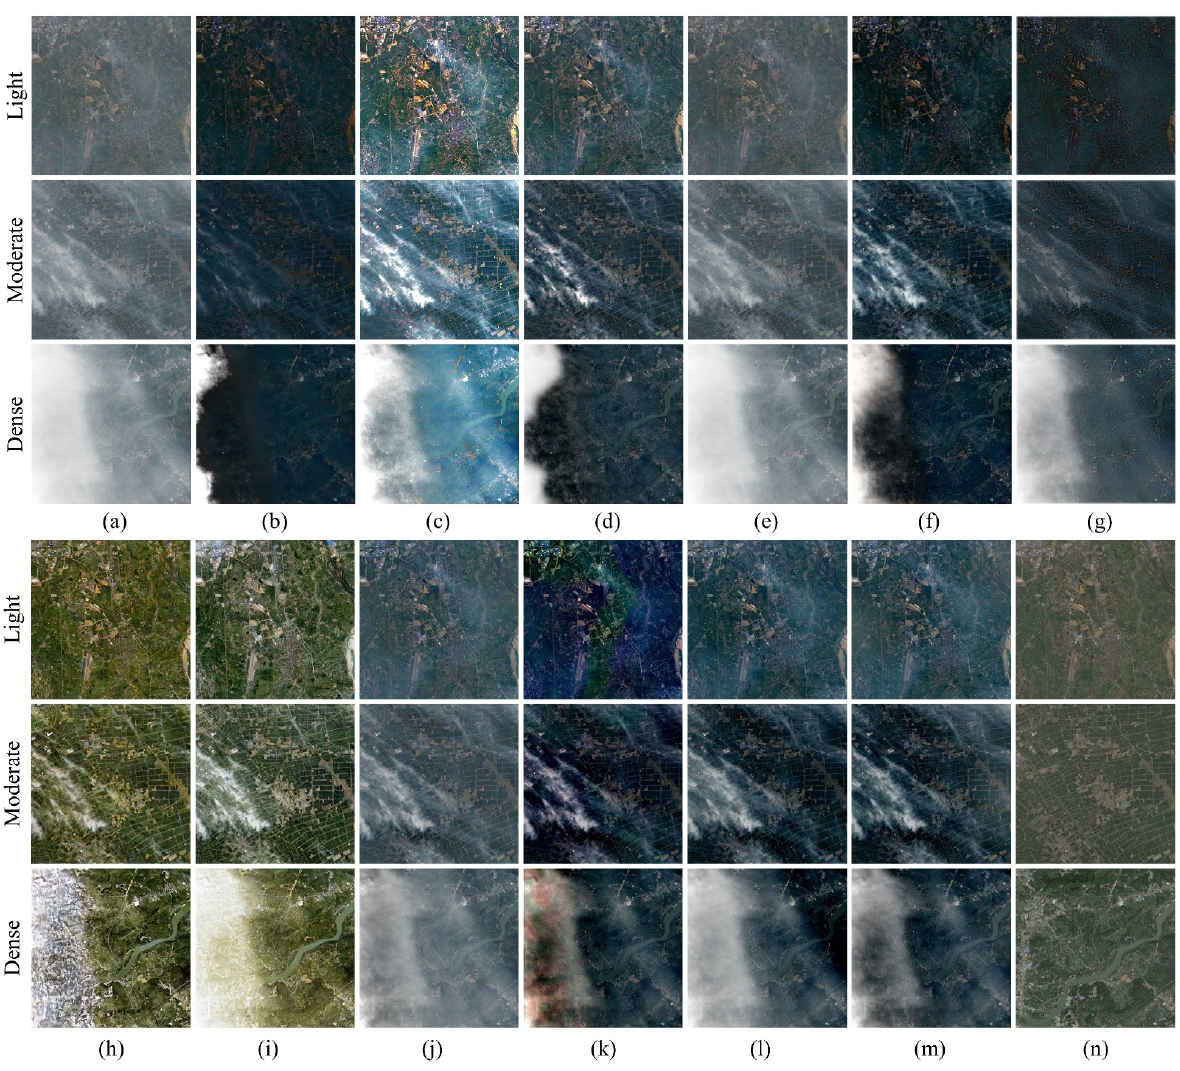
Figure 6. Comparisons with SOTA dehazing methods on the RS-Haze dataset. ( a ) Hazy input image. ( b ) DCP. ( c ) MOF. ( d ) BCDP. ( e ) FFA. ( f ) EMRA. ( g ) LDN. ( h ) AESUN. ( i ) TBNN. ( j ) DDIP. ( k ) ZID. ( l ) YOLY. ( m ) Our method. ( n ) Ground truth.